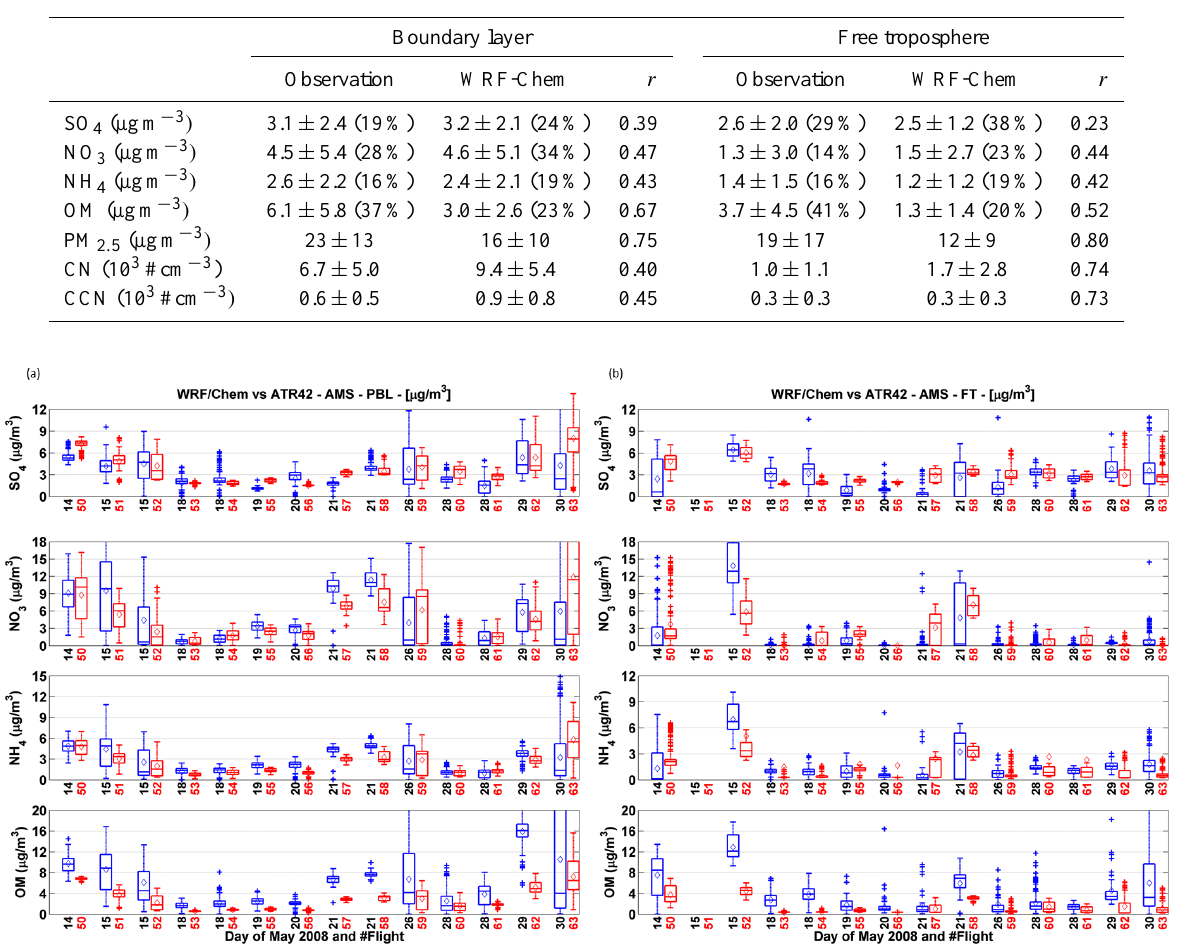
Figure 6. Box plot of SO 4 , NO 3 , NH 4 , and OM mass concentrations measured by AMS aboard the ATR-42 (blue) and simulated by WRF- Chem (red) within boundary layer (a) and free troposphere (b) . The x axis reports the day of May 2008 (black) and the number of the research flight (red). The whisker plots denote median, 25th and 75th percentiles, 1.5 × (inter-quartile range), and outliers. The squares represent the mean